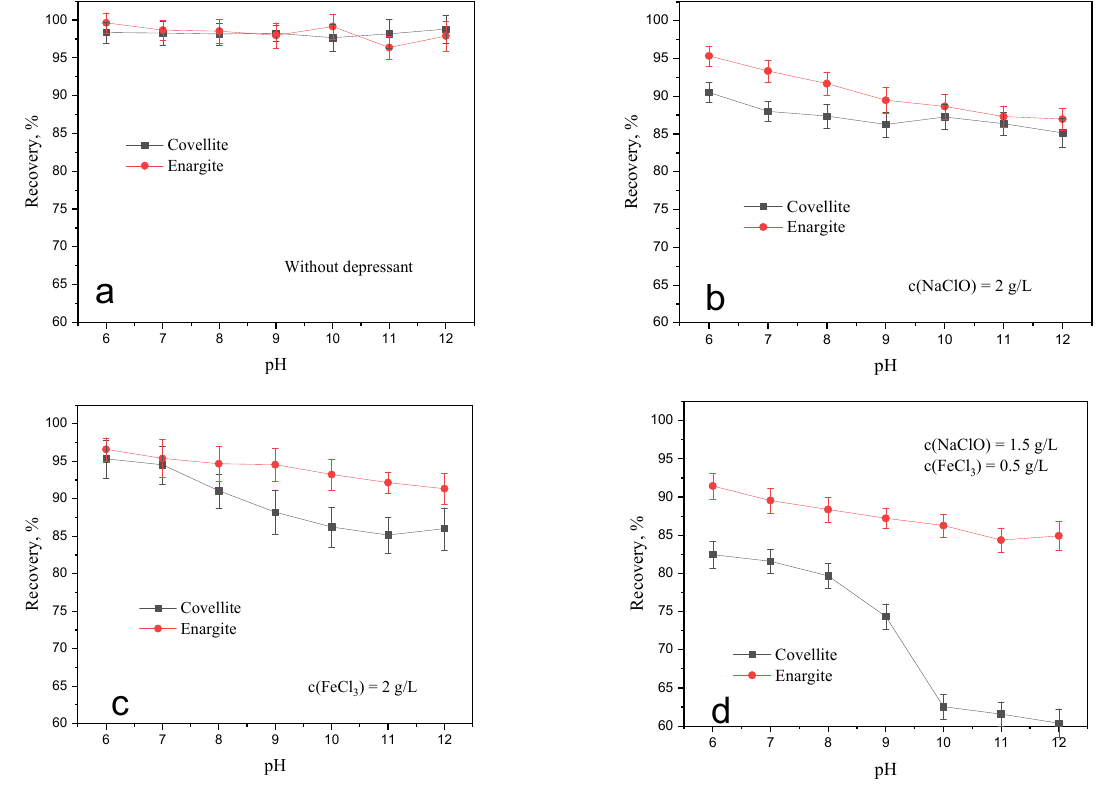
Figure 3. Effect of oxidation treatment on the recovery of covellite and enargite at different pH levels: ( a ) without depressant, ( b ) NaClO, ( c ) FeCl 3 , ( d ) NaClO + FeCl 3 .